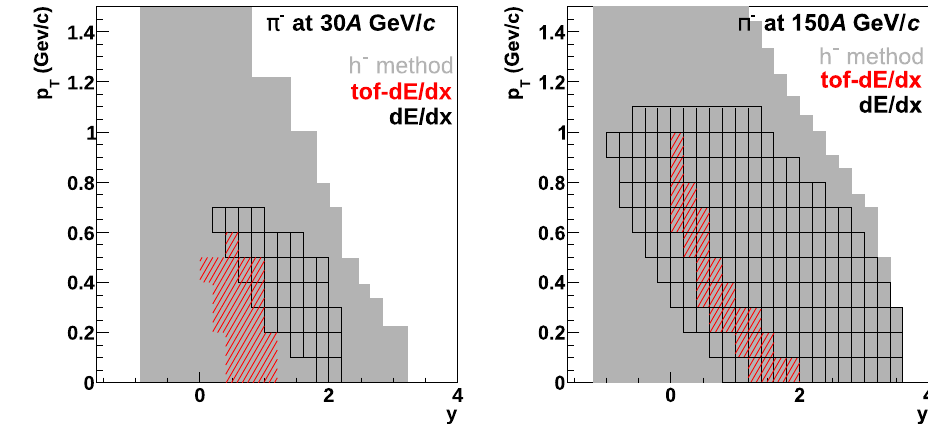
Fig. 5 Acceptance in y and p T of analysis techniques used by NA61/SHINE to obtain multiplicities of π − produced in Be + Be collisions at 30 A (left) and 150 A GeV / c (right). Acceptance for the h − method is shown as gray area, for the d E / d x identification technique as black boxes and for the tof -d E / d x identification as red